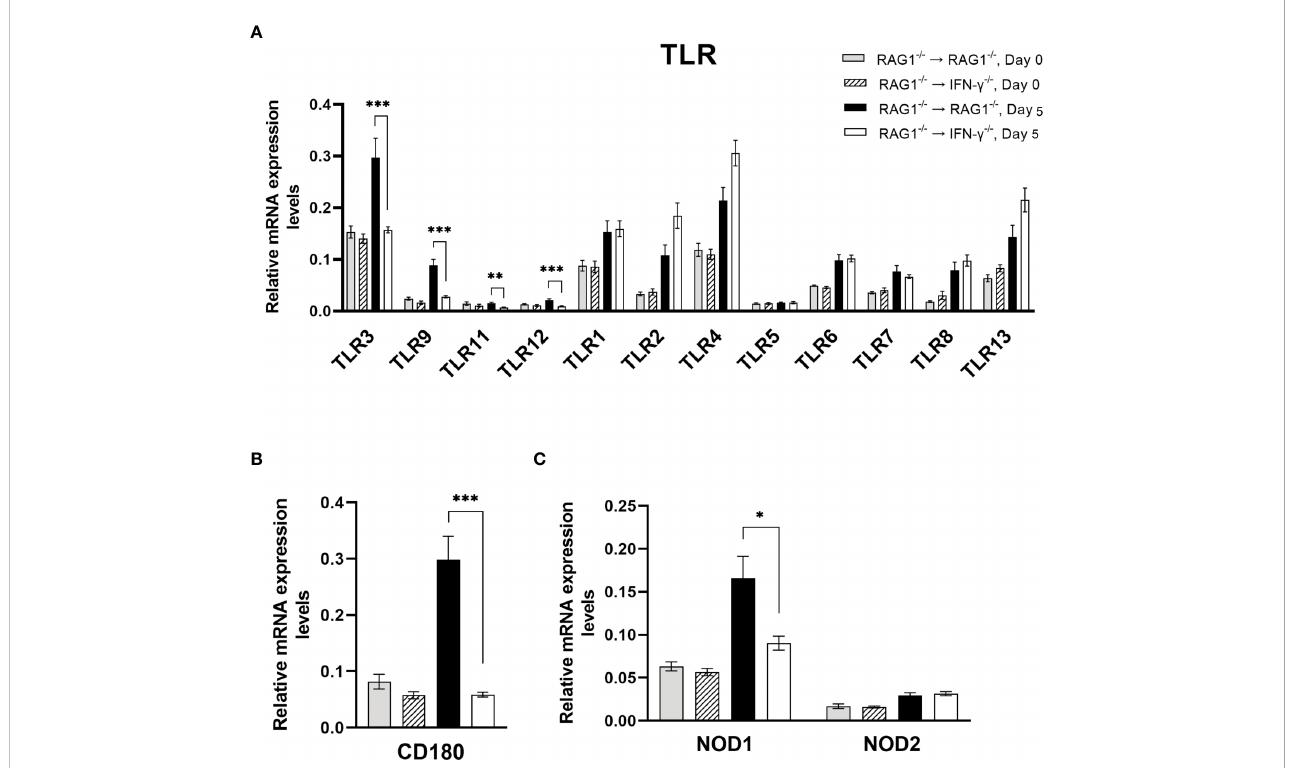
FIGURE 4 Cerebral mRNA levels for the molecules that recognize the pathogen-associated molecular patterns are upregulated by IFN- g production by brain- resident cells during reactivation of cerebral T. gondii infection. For the details of experimental methods, see the legend of Figure 1. The mRNA levels for